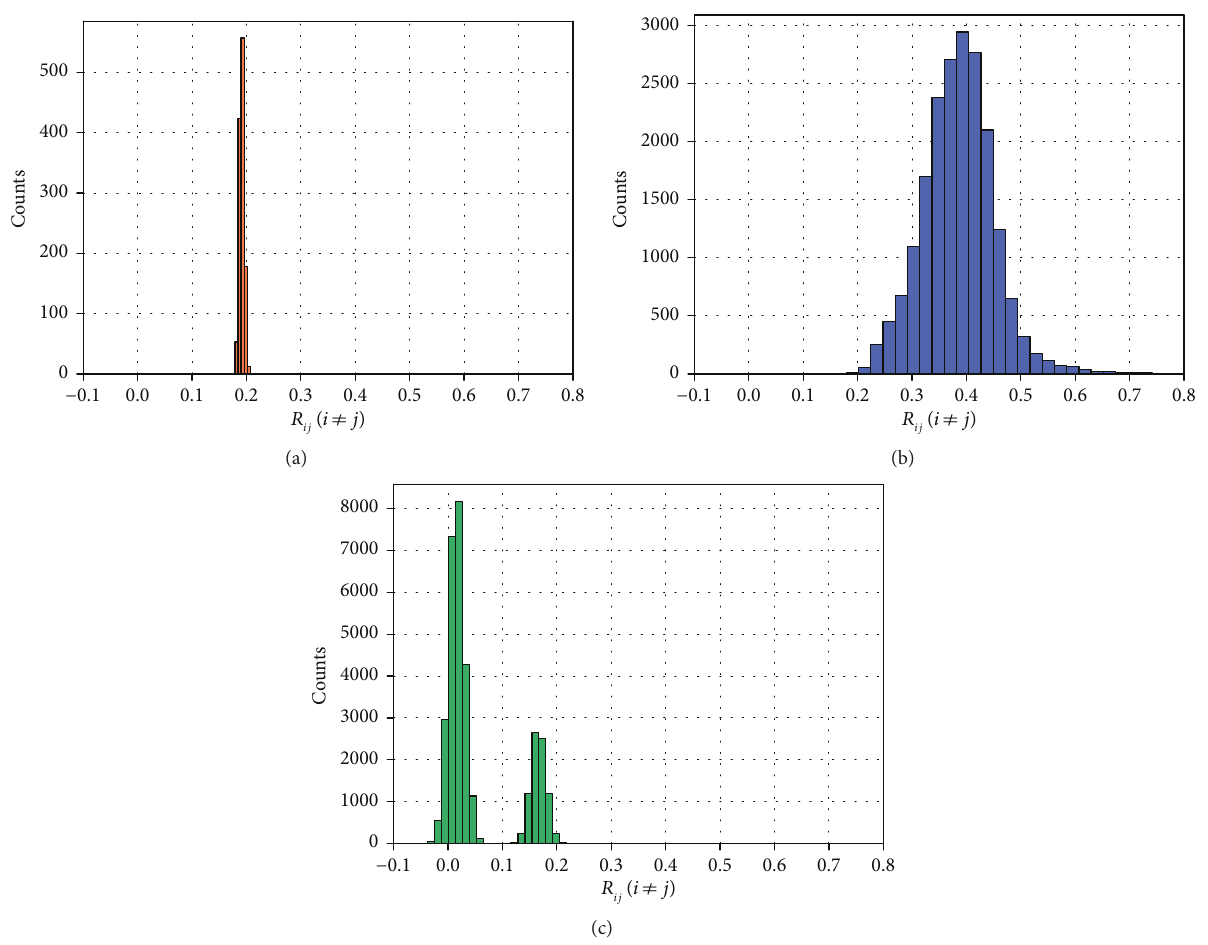
Figure 8: Histogram of the correlation between variables, R , for 3 distinct network topologies: Erdös-Rényi of size N = 50 and edge ij probability p = 0 4 (a), heterogeneous network of size N = 200 and degree distribution exponent α = 2 9 (b), and Newman modular of size N = 256 , k in = 15 and k total = 16 (c). The histogram captures the e ff ect of G N , μ on R N , μ . Correlation matrix is computed from analytic metric stable state (8) of 5000 generated individuals. The distribution of correlations between variables connected as an ER network is peaked at a certain value, whereas assuming a heterogeneous network leads to a much broader spectrum of correlation values. The Newman modular network brings about two clear peaks, corresponding to intracluster and intercluster correlations. Parameters of the model are set for all nodes to C = 5 and K = 1 for all networks, r = 1 and w = 0 03 for Erdös-Rényi network, r = 0 5 and w = 0 025 for heterogeneous network, and r = 0 05 and w = 0 015 for Newman modular